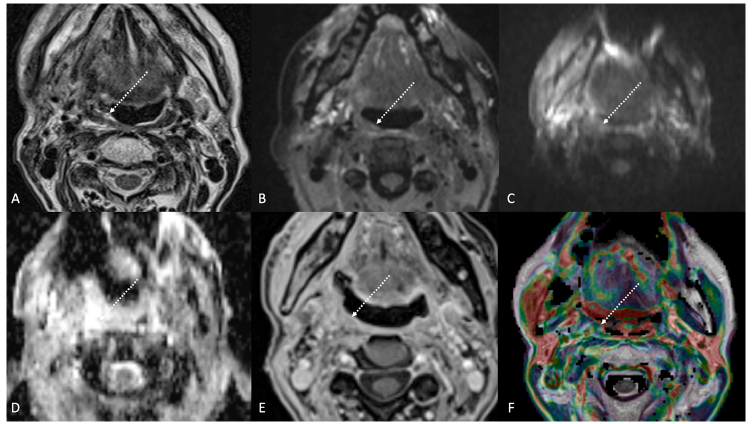
Figure 3. Post-treatment magnetic resonance imaging (MRI) of a 63-year-old female patient with human-papillomavirus-positive carcinoma of the right palatine tonsil with ipsilateral lymph node metastasis (T2N1) recently treated (3 months before) with chemoradiotherapy (CRT). Post-CRT MRI showed linear fibrotic tissues in the right palatine tonsil (white striped arrows) with hypointense signal intensity on T2-weighted ( A ), T2-weighted fat-saturated, ( B ) and diffusion-weighted b800 images ( C ), and intermediate apparent diffusion coefficient values (1.44 × 10 − 3 mm 2 /s) ( D ). After gadolinium contrast agent injection, post-CRT fibrotic tissue showed no submucosal enhancement ( E ) and low K(trans) value (48.36 × 10 − 3 mm 2 /s) on dynamic contrast enhancement-perfusion weighted imaging ( F ). Ratio between K(trans) values of the primitive tumor and residual tissue after CRT, standardized with respect to K(trans) value of the ipsilateral trapezius (K(trans)post/pre/muscle), was 0.307. These findings are typical of post-CRT scar tissue.